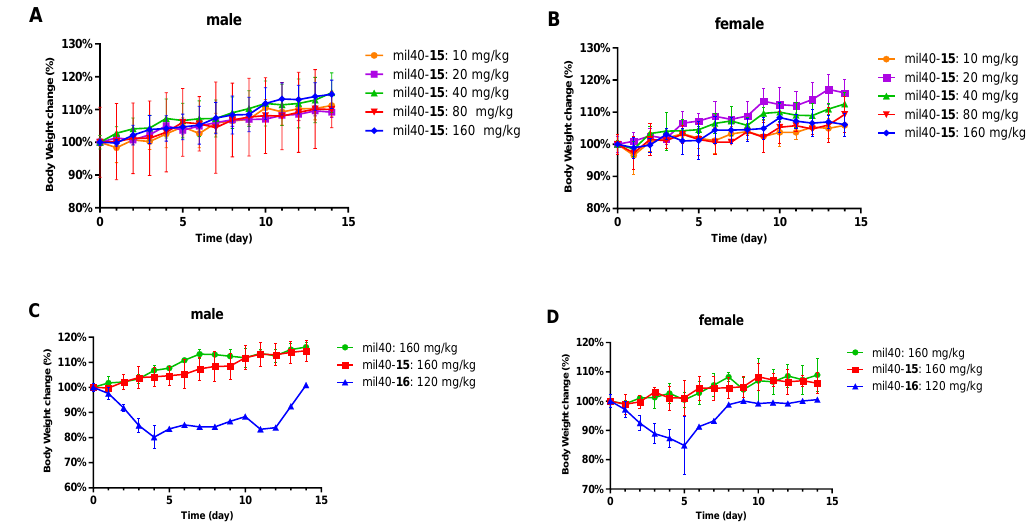
Figure 9. Tolerance study of the Cys-linker-MMAE-based ADC. ( A ) Body weight changes in male mice after administration of mil40- 15 . ( B ) Body weight changes in female mice after administration of mil40- 15 . ( C ) Body weight changes in male mice after administration of mil40, mil40- 15 , and mil40- 16 . ( D ) Body weight changes in female mice after administration of mil40, mil40- 15 , and mil40- 16 . The results are shown as the mean ± SD, n = 3/group.